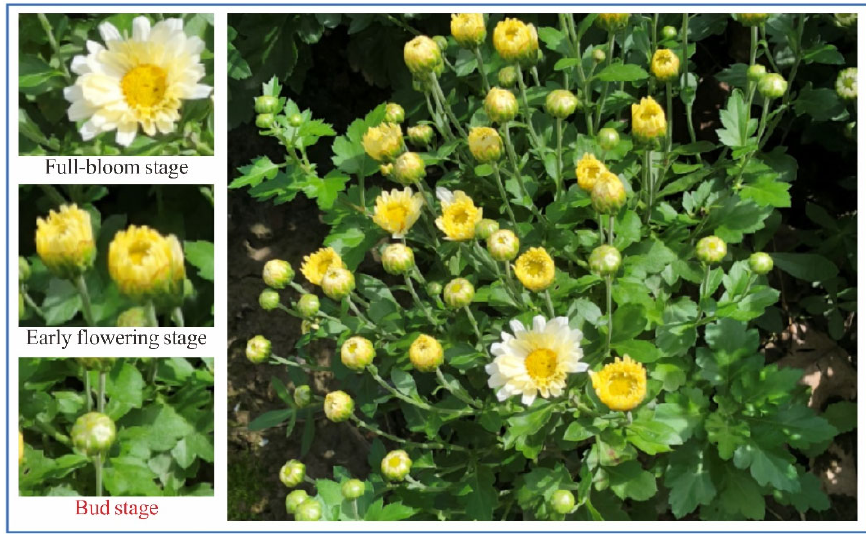
Figure 1. The different flowering stages of medicinal chrysanthemums.